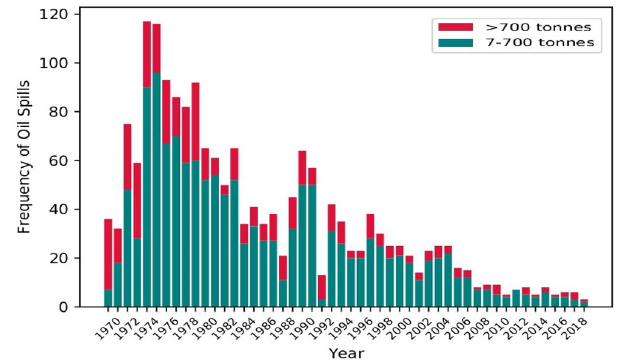
Figure 1. Oil spill occurrences from tanker incidents worldwide from 1970−2010 (Source: (ITOPF,